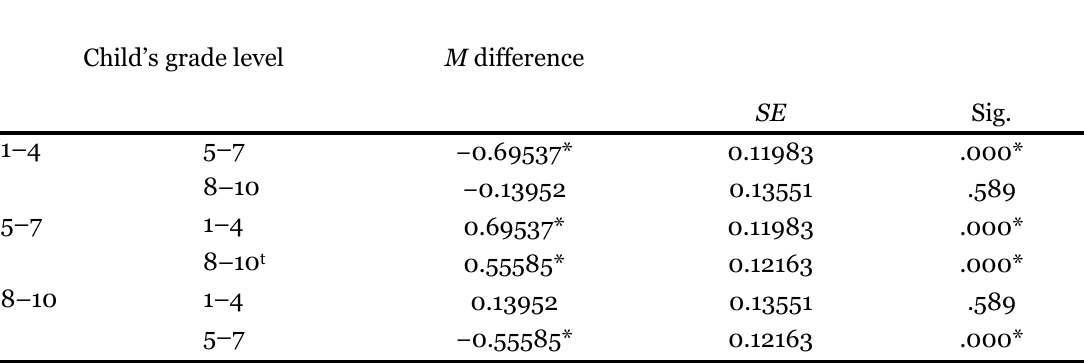
Schiff’s Post Hoc Test Results of Parents’ Perceptions Toward the Distance Learning Process According to Child’s Grade Level